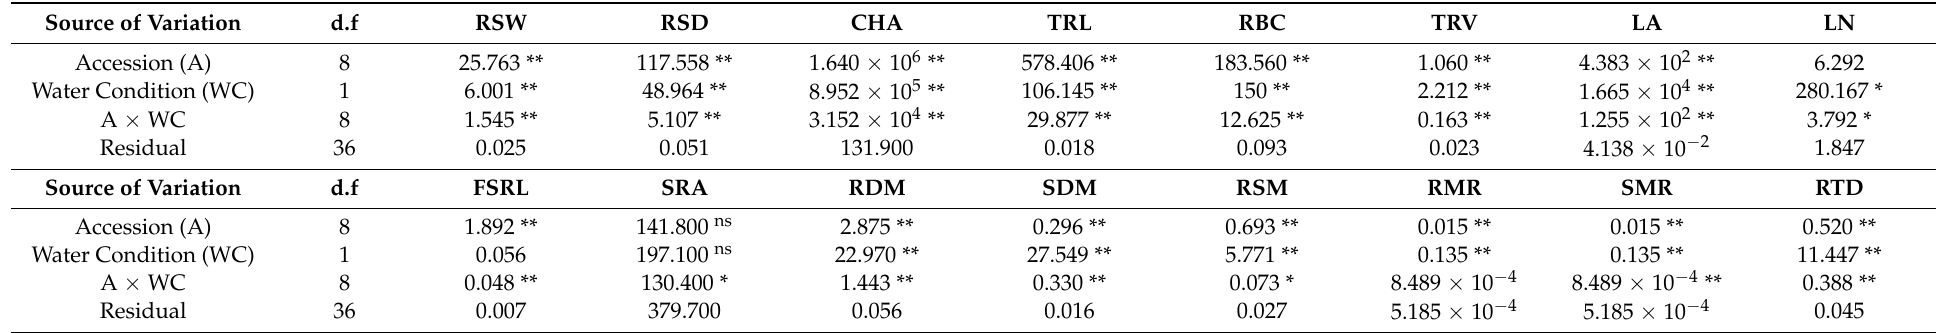
Table 2. Analysis of variance showing mean squares and significant tests for root and leaf of nine citron watermelon landrace accessions evaluated under non-stressed and water-stressed